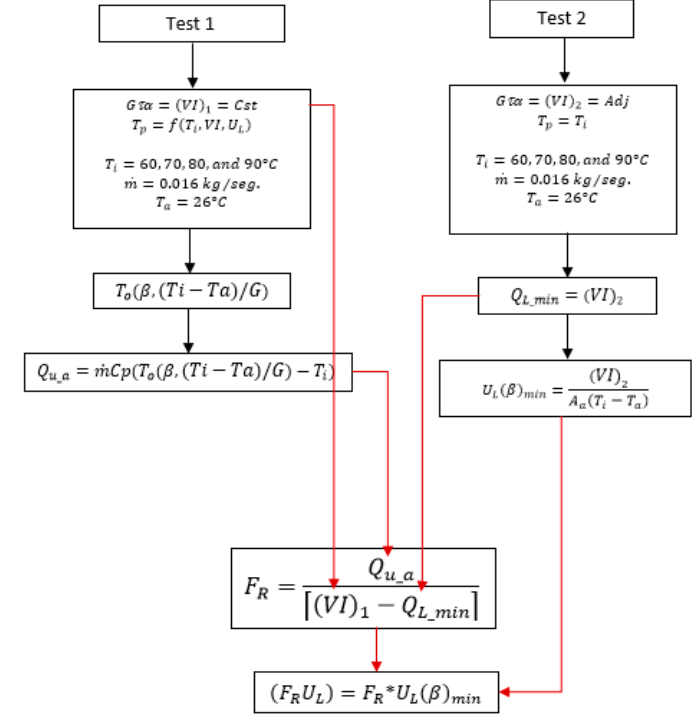
Figure 3. Mathematical model.